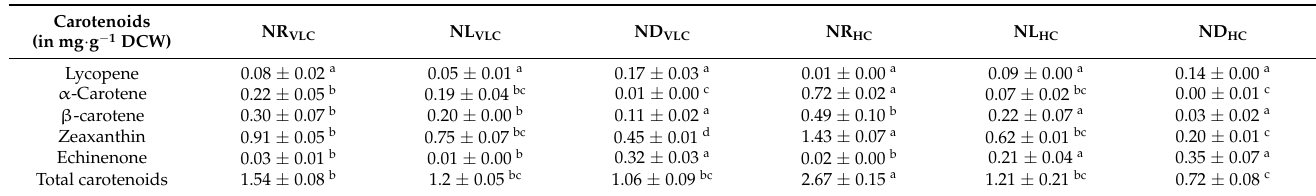
Table 4. Estimation of carotenoid yields (in mg · g − 1 DCW) on the 10th day subjected to NR VLC , NL VLC , ND VLC , NR HC , NL HC , and ND HC conditions in the native isolate Monoraphidium sp. CABeR41. Values indicated are mean average ( n = 3) ± S.E.; different lowercase letters indicate the statistical significance by two-way ANOVA with p -value < 0.05 using post hoc analysis by Tukey’s honestly significant difference